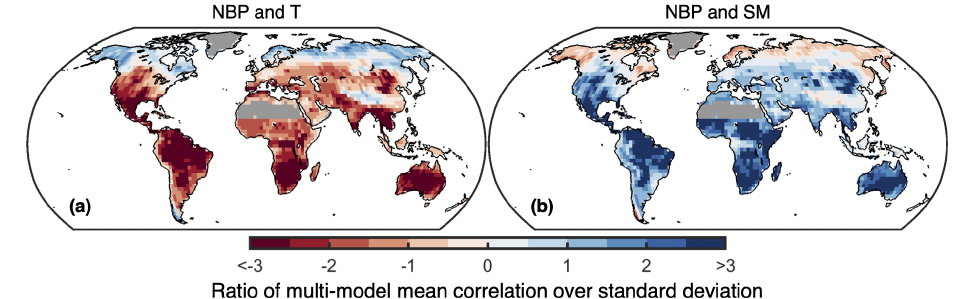
Figure 3. Model agreement on the sensitivity of NBP to temperature and soil moisture. Shown is the ratio of the multi-model mean over the multi-model standard deviation for (a) the correlation between detrended annual NBP and detrended annual warm-season temperature and for (b) the correlation between detrended annual NBP and detrended annual warm-season soil moisture. Lighter colors indicate weaker correlations and/or higher model disagreement. Regions with 2015–2100 average GPP below 100gCm 2 yr − 1 are